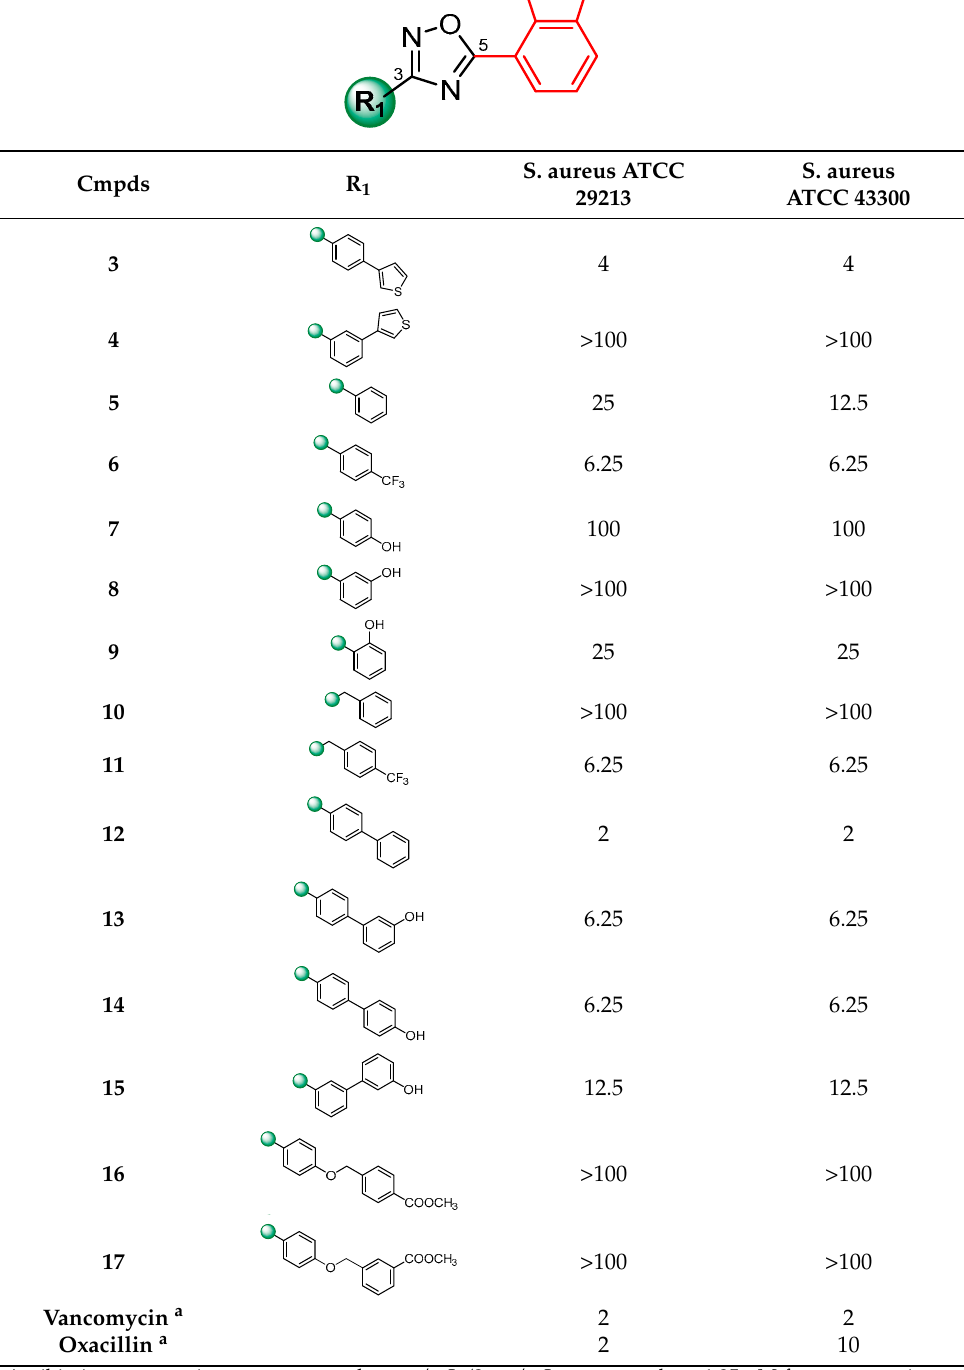
Table 1. In vitro antimicrobial activity of compounds 3 – 17, MIC values are expressed as µM.